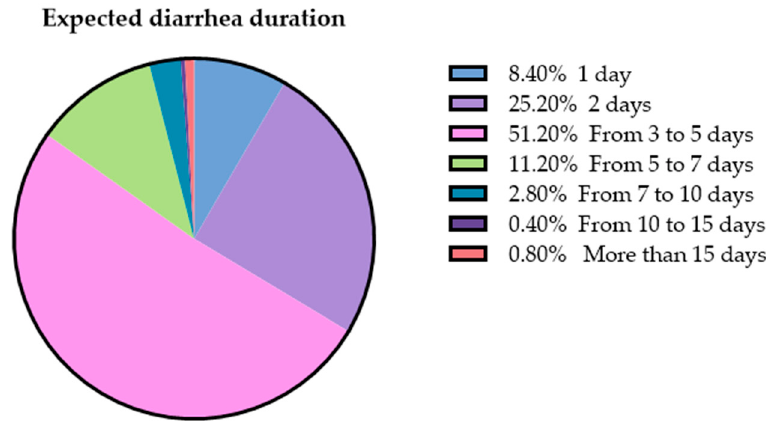
Figure 3. Reasons why, according to respondents, an antibiotic is needed to treat acute diarrhea in dogs.